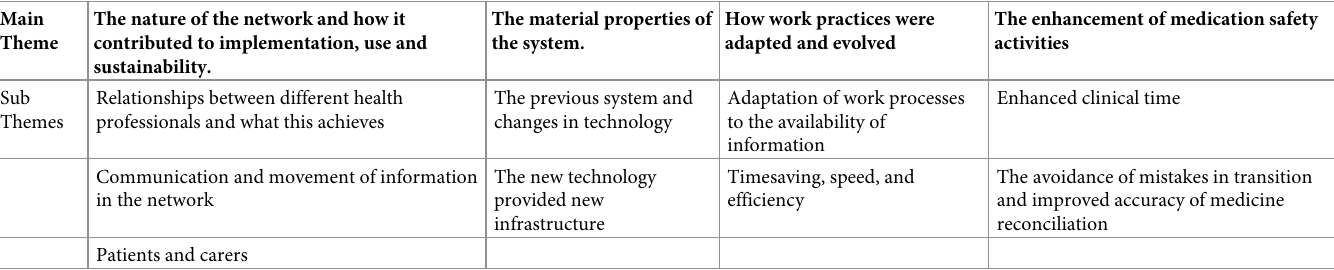
Table 2. Themes and sub